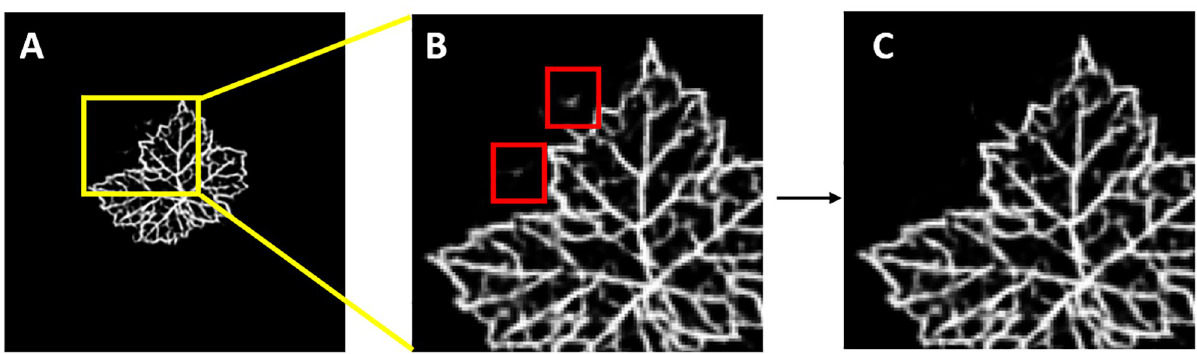
Fig 8. Refinement algorithm. The generative procedure sometimes produces artifacts, that is leaf regions that appear outside the leaf blade. These artifacts are corrected by procedurally finding the contours of all the objects in the image and removing the objects outside the leaf contour. A: first leaf in Fig 6 presenting artifacts; B: inset showing the magnified artifacts; C: cleaned leaf.